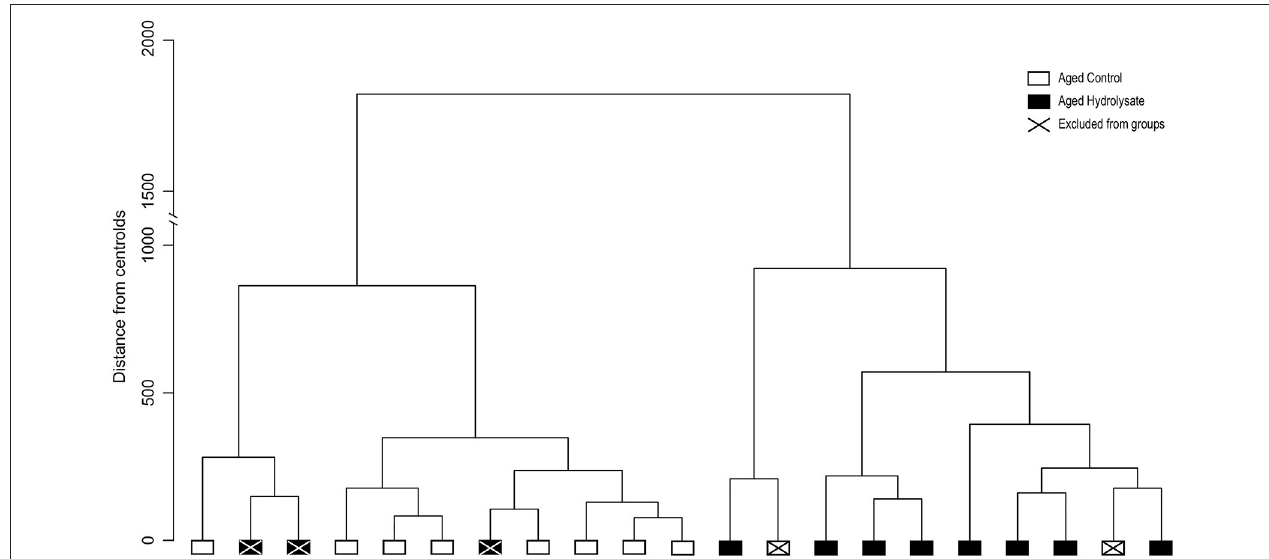
FIGURE 2 | Unsupervised hierarchical cluster dendrogram of individuals using Ward’s linkage method. Dendrogram of the two clusters corresponding to control fed mice (white) and mice fed the hydrolysate-enriched diet (black). Mice removed from analyses are represented with a cross. Such analyses are based on cognitive behavior, central and intestinal inflammatory cytokines, microglial and intestinal permeability markers ( Table 2